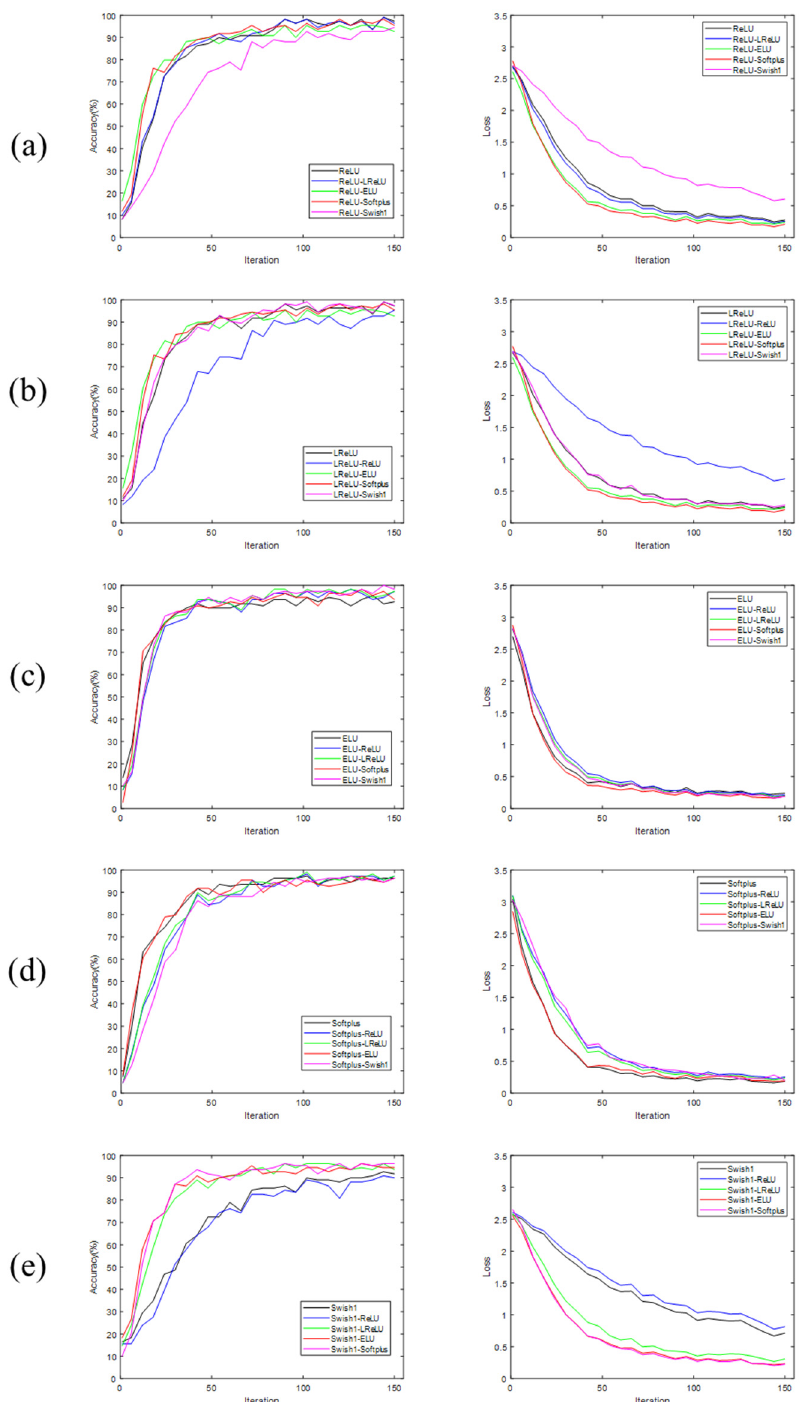
Figure 10. Validation accuracy and loss curves for twenty ResNet50 networks improved by mixed activation functions. (where ( a – e ) are the network training results of taking ReLU , LReLU , ELU , Softplus, and Swish1 as the first activation function after addition operation, and the other four functions are separately used at other locations of the network structure).